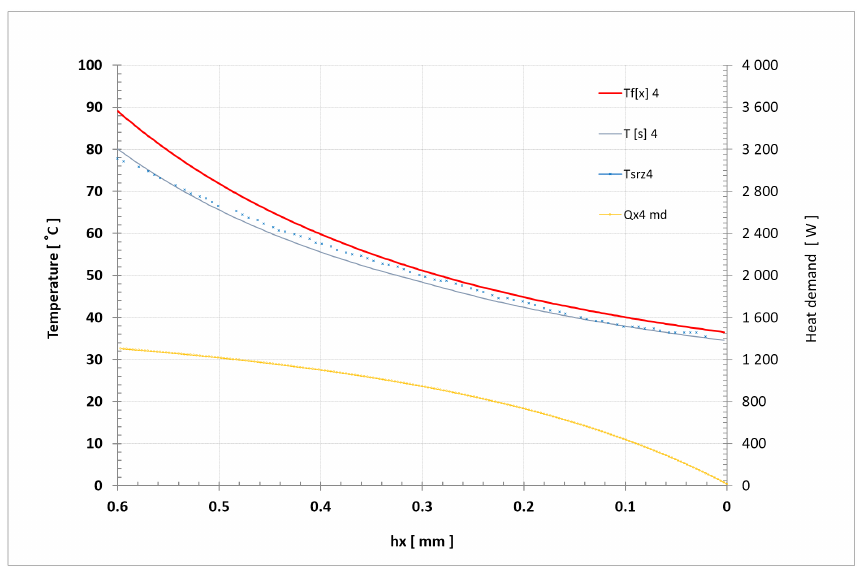
Figure 24. Delonghi -22 comparison of measurement and calculations results of water temperature, radiator surface temperature and radiator heat out distribution—measurement 4, t s = 89.7 ◦ C, t r = 37.1 ◦ C, t i = 19.7 ◦ C, q mx = 0.0059 kg/s, ( q m . min ) .